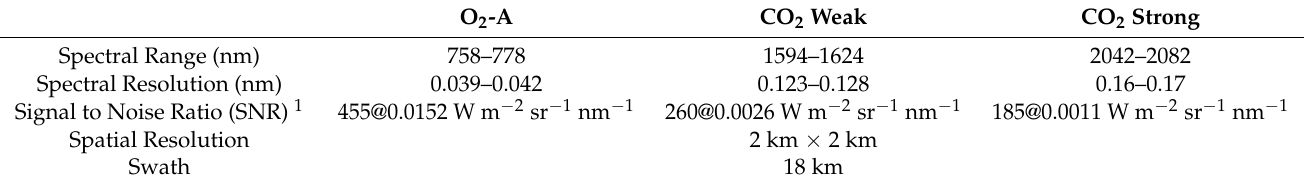
Table 1. Specifications of key characteristics of the Atmospheric Carbon Dioxide Grating Spectrometer (ACGS). O 2 -A CO 2 Weak CO 2 Strong Spectral Range (nm)